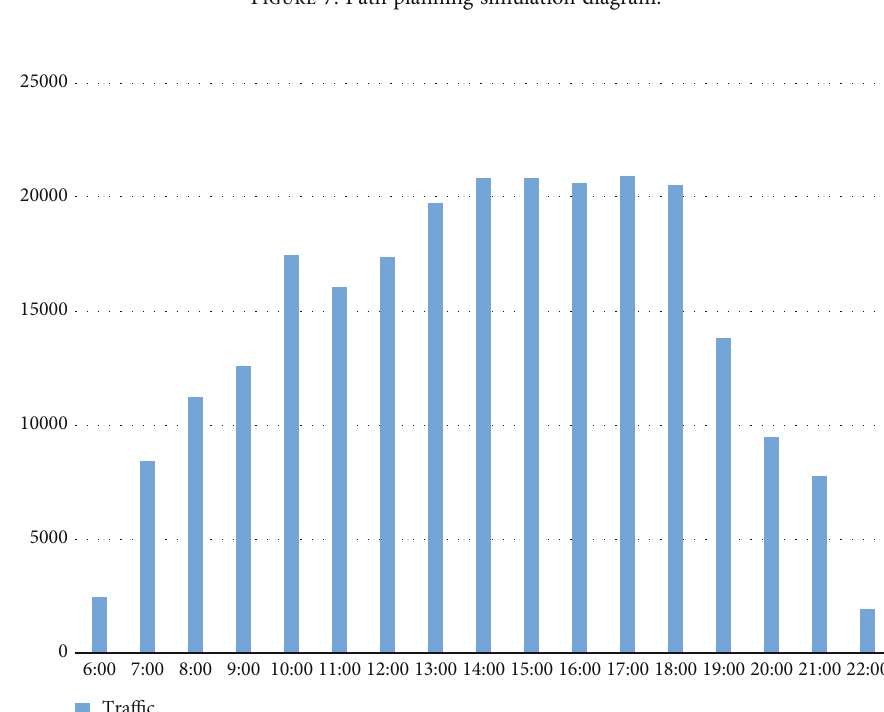
Figure 7: Path planning simulation